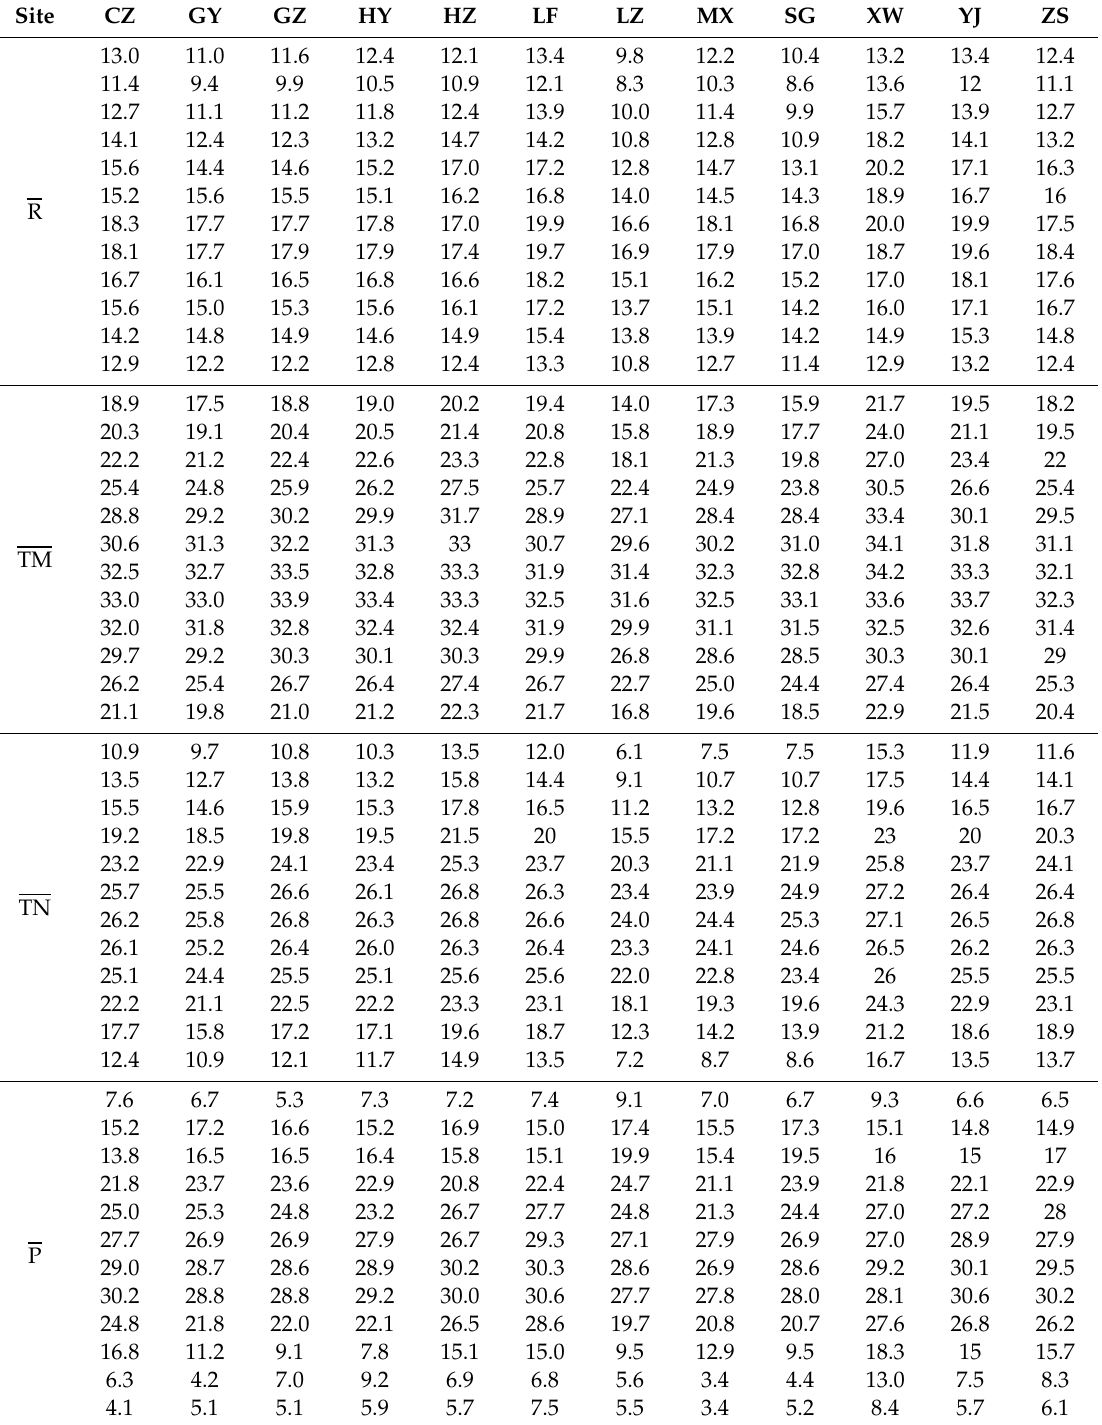
Table A5. Climate patterns under the 1.5 ◦ C warming